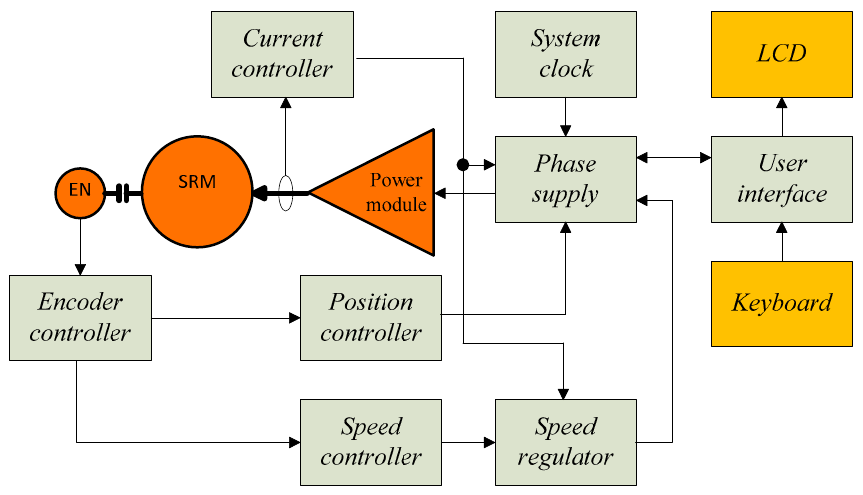
Figure 5. Structure of the system with the proposed regulator.